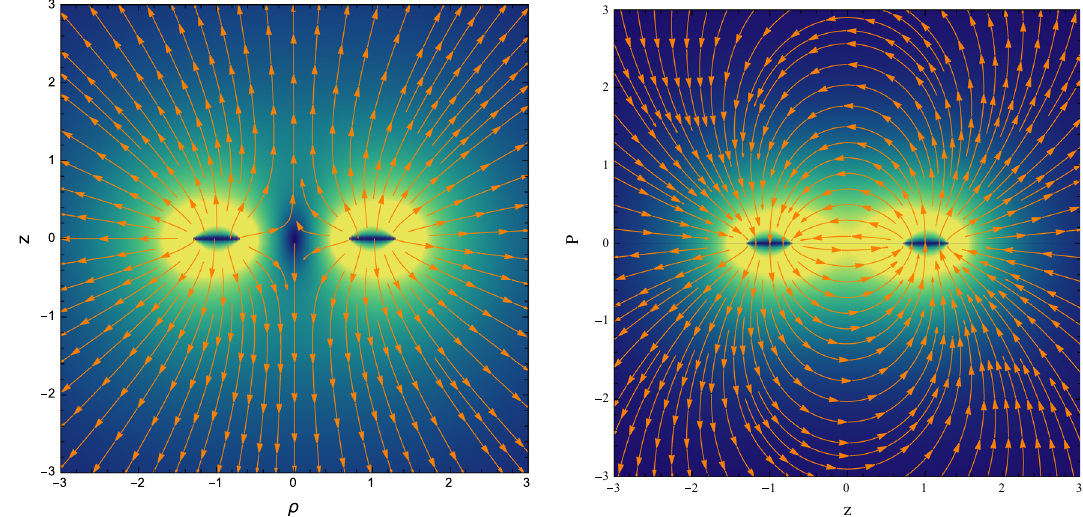
Fig. 2 Electromagnetic structure of a two like magnetic monopole field ( left ) and a magnetic dipole field ( right ) in a (equal mass) binary black hole system